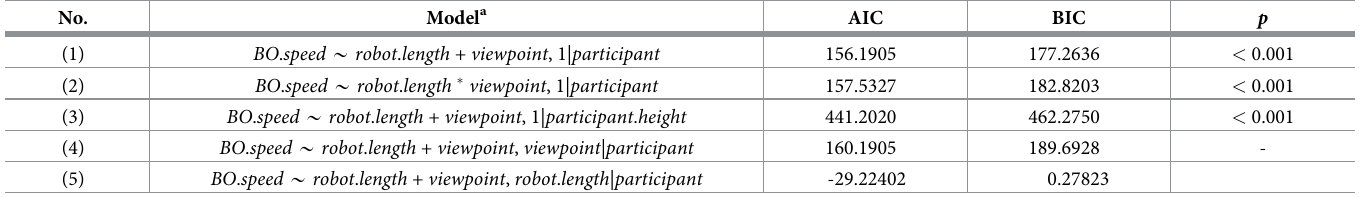
Table 4. Model selection for back-off speed using information criteria AIC, BIC, and p-value between model (5) and the models (1)–(4).